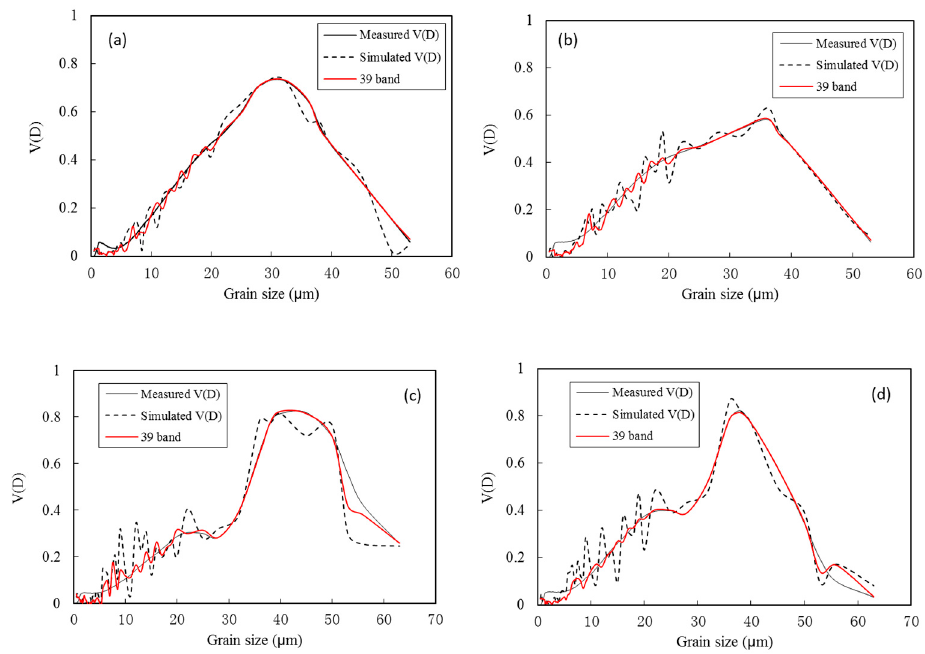
Figure 6. Comparison of the simulated typical particle size percentage distribution curves over the study area with the measurement results. The simulated V (D) was 18 wavebands. ( a – d ) denote the four types of particle size distribution curves measured from November 13 to 21, 2004 in Heini Bay.